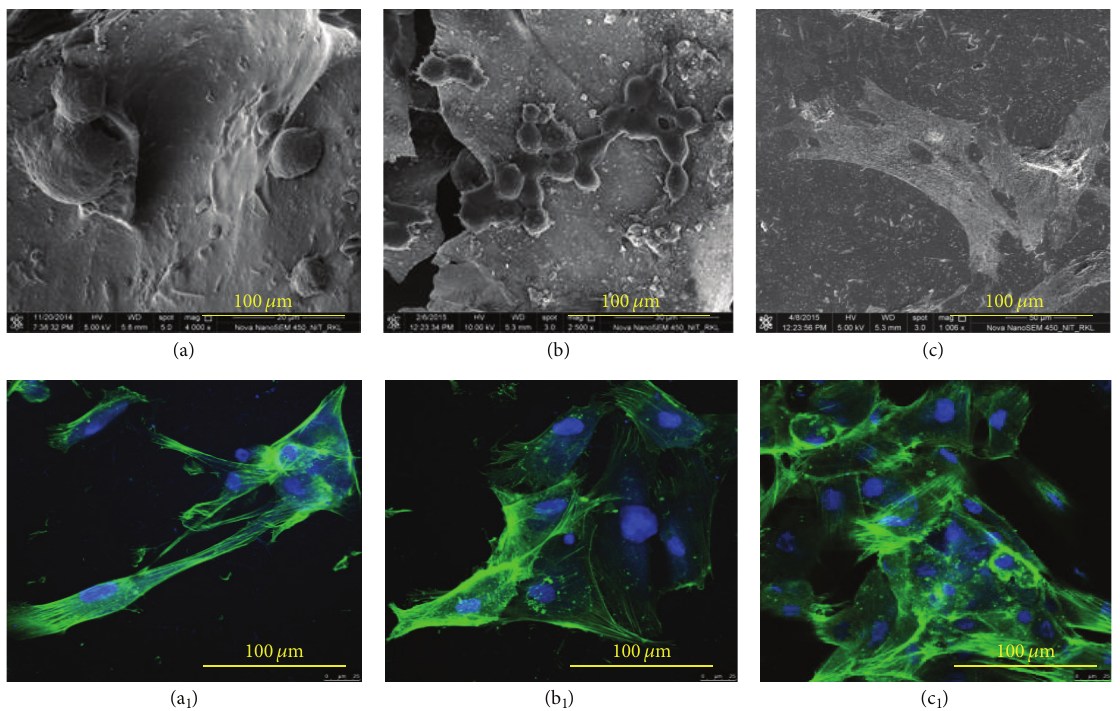
Figure 12: FESEM image of MSC on gelatin-chitosan-bioglass (GCB 30) for (a) 1d, (b) 3 d, and (c) 14 d of cell culture. Confocal images of cytoskeleton of MSC on GCB 30 ((a 1 ), (b 1 ), and (c 1 )).